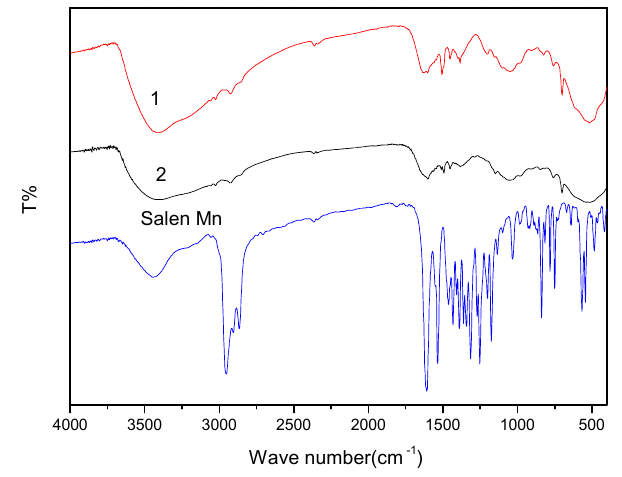
Figure 1. FT-IR spectra of catalysts 1 and 2 and chiral Mn III (Salen) (Jacobsen’s catalyst 4).